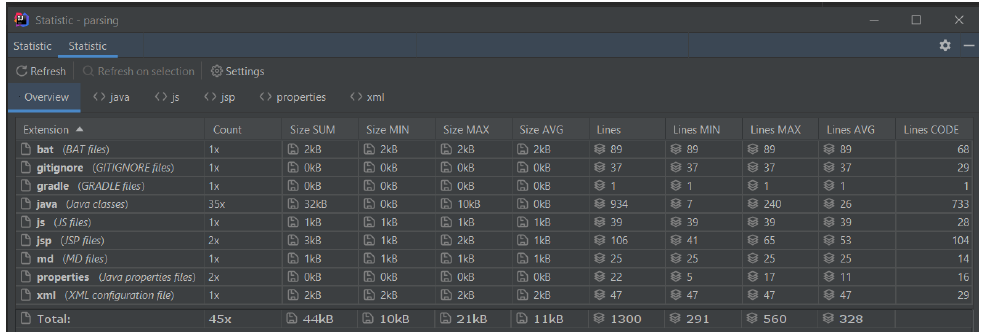
Figure 11. The statistics of the parser web